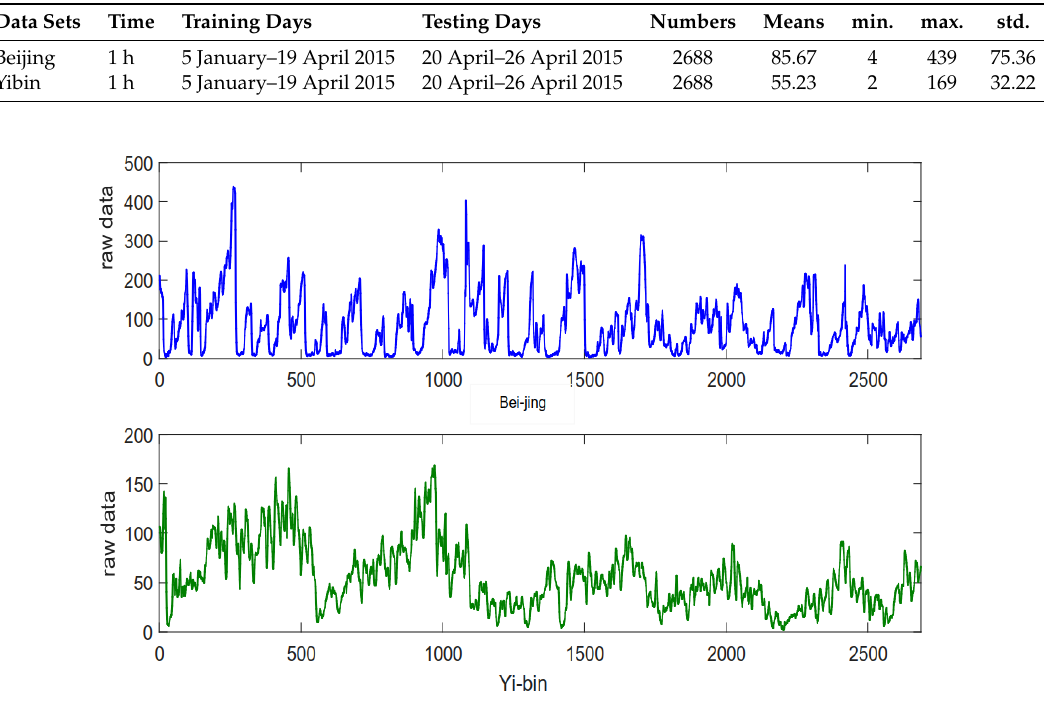
Table 1. The basic statistics information of the PM 2.5 raw data in Beijing and Yibin of China.